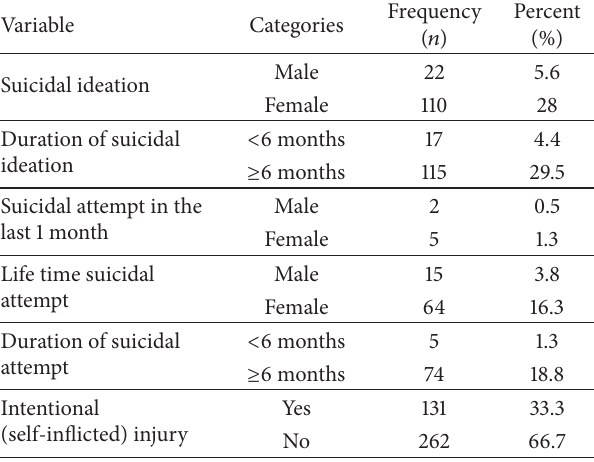
Table 4: Suicidal ideation and attempt among respondents attend- ing ART clinic at Debark Hospital Northwest, Ethiopia,